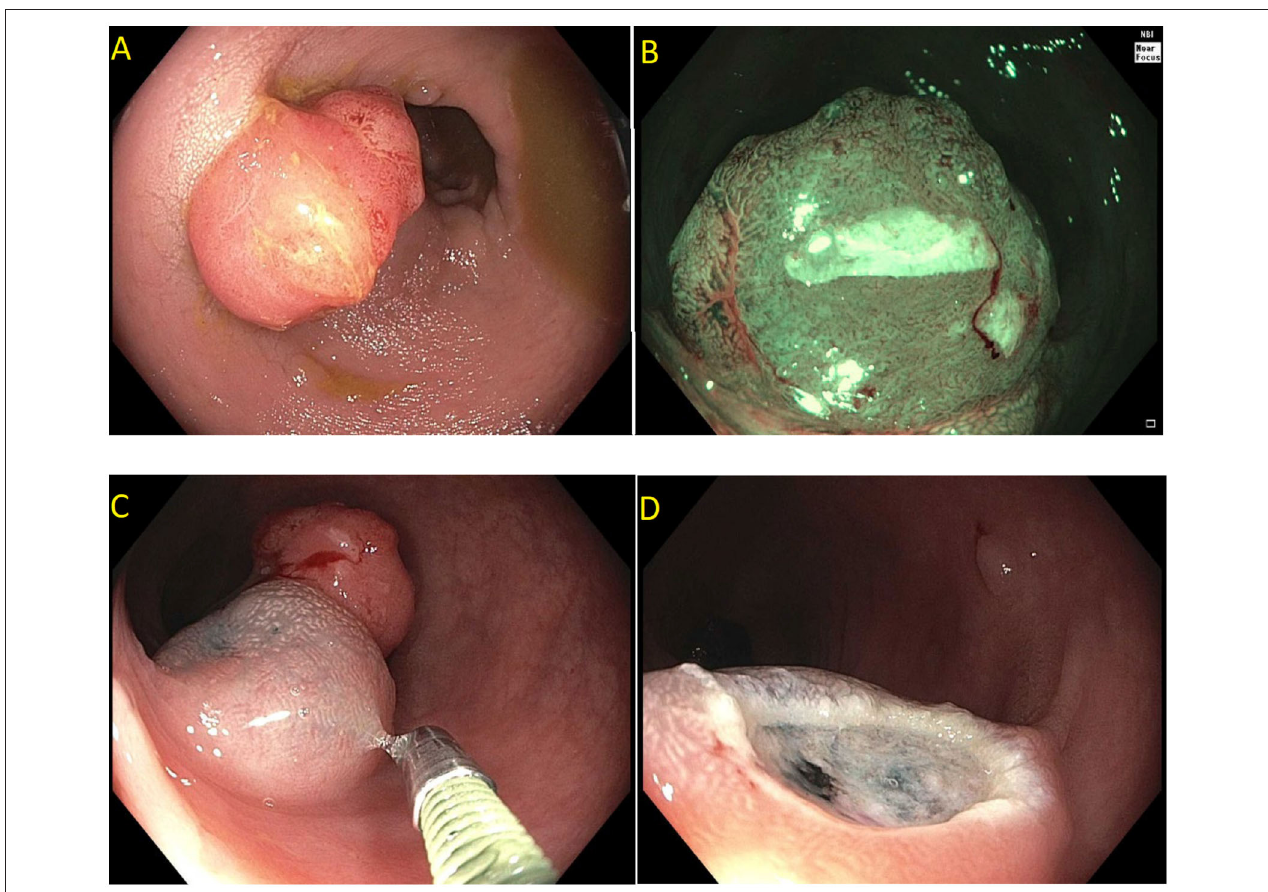
FIGURE 2 | Paris is lesion in the rectum. (A) Seen on white light; (B) Seen on Narrow Band Imaging (NBI); (C,D) Polyp raised and resected en bloc. Histology revealed a superficial ( < 1mm) T1 tumor with lymphovascular